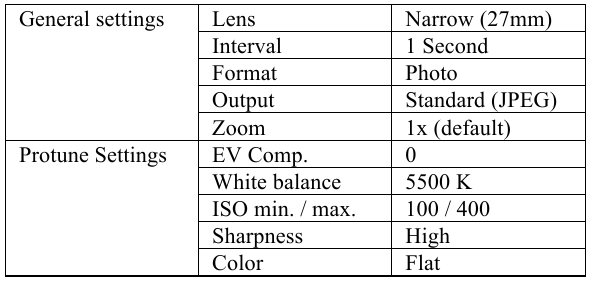
Table 2 . Technical settings of the GoPro HERO8 camera used for the compact underwater cave photogrammetry setup